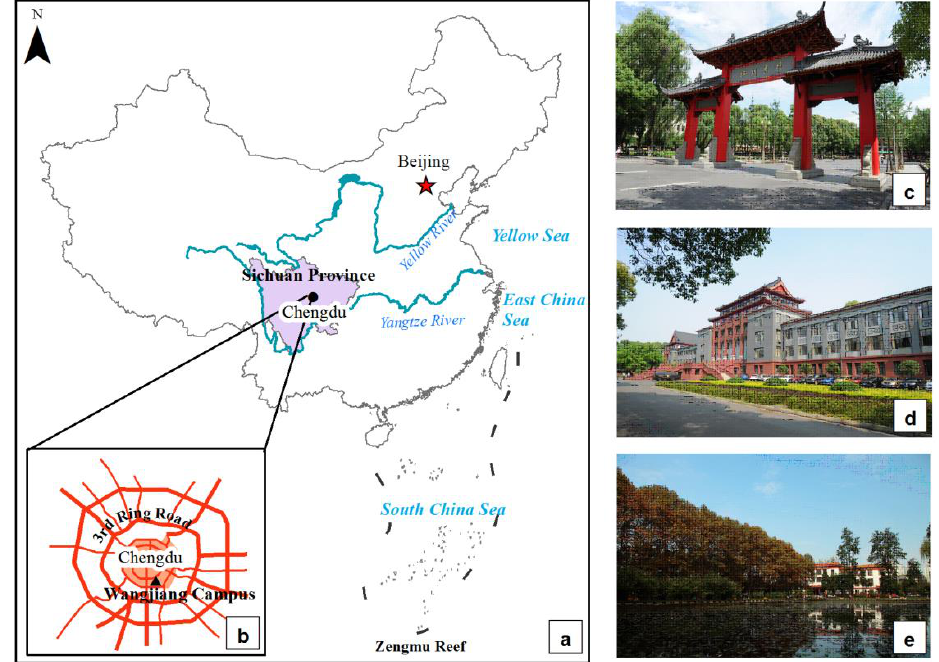
Figure 2. Location of Wangjiang Campus of Sichuan University and some typical buildings. ( a ) Chengdu’s position in China; ( b ) Road network of Chengdu and location of Wangjiang Campus